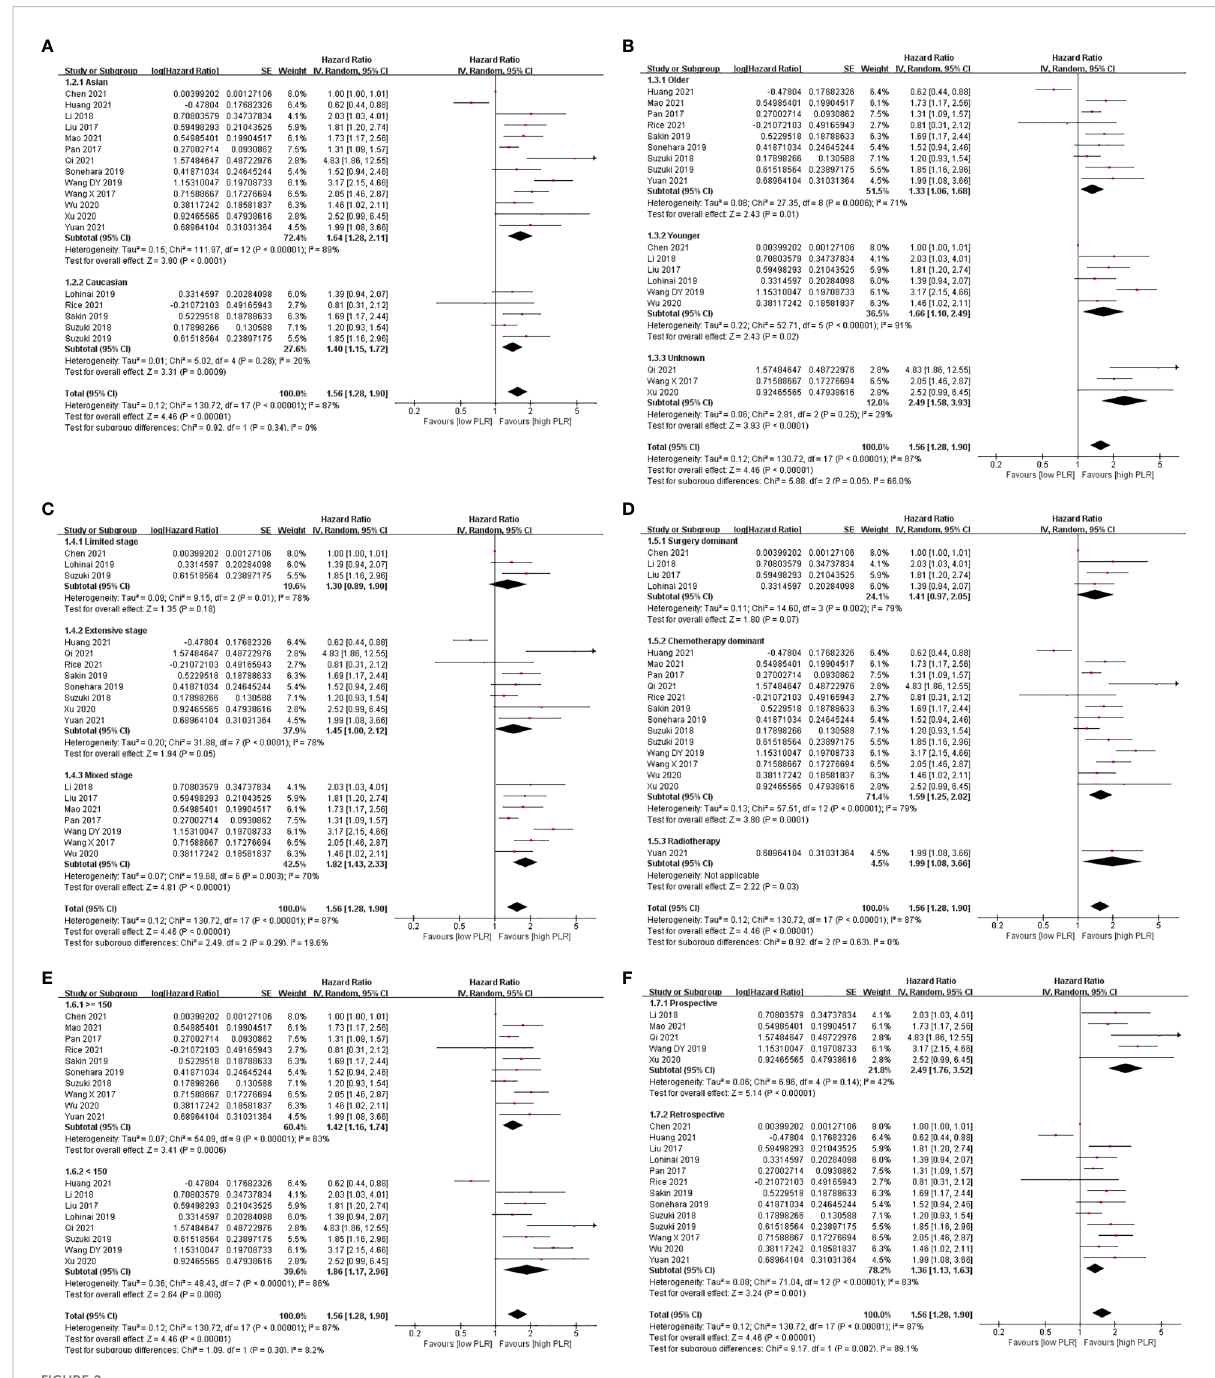
FIGURE 2 Subgroup analysis of associations between PLR and OS in SCLC patients summarized by univariate model. (A) Ethnicity; (B) age; (C) stage; (D) treatment; (E) cutoff point; (F)